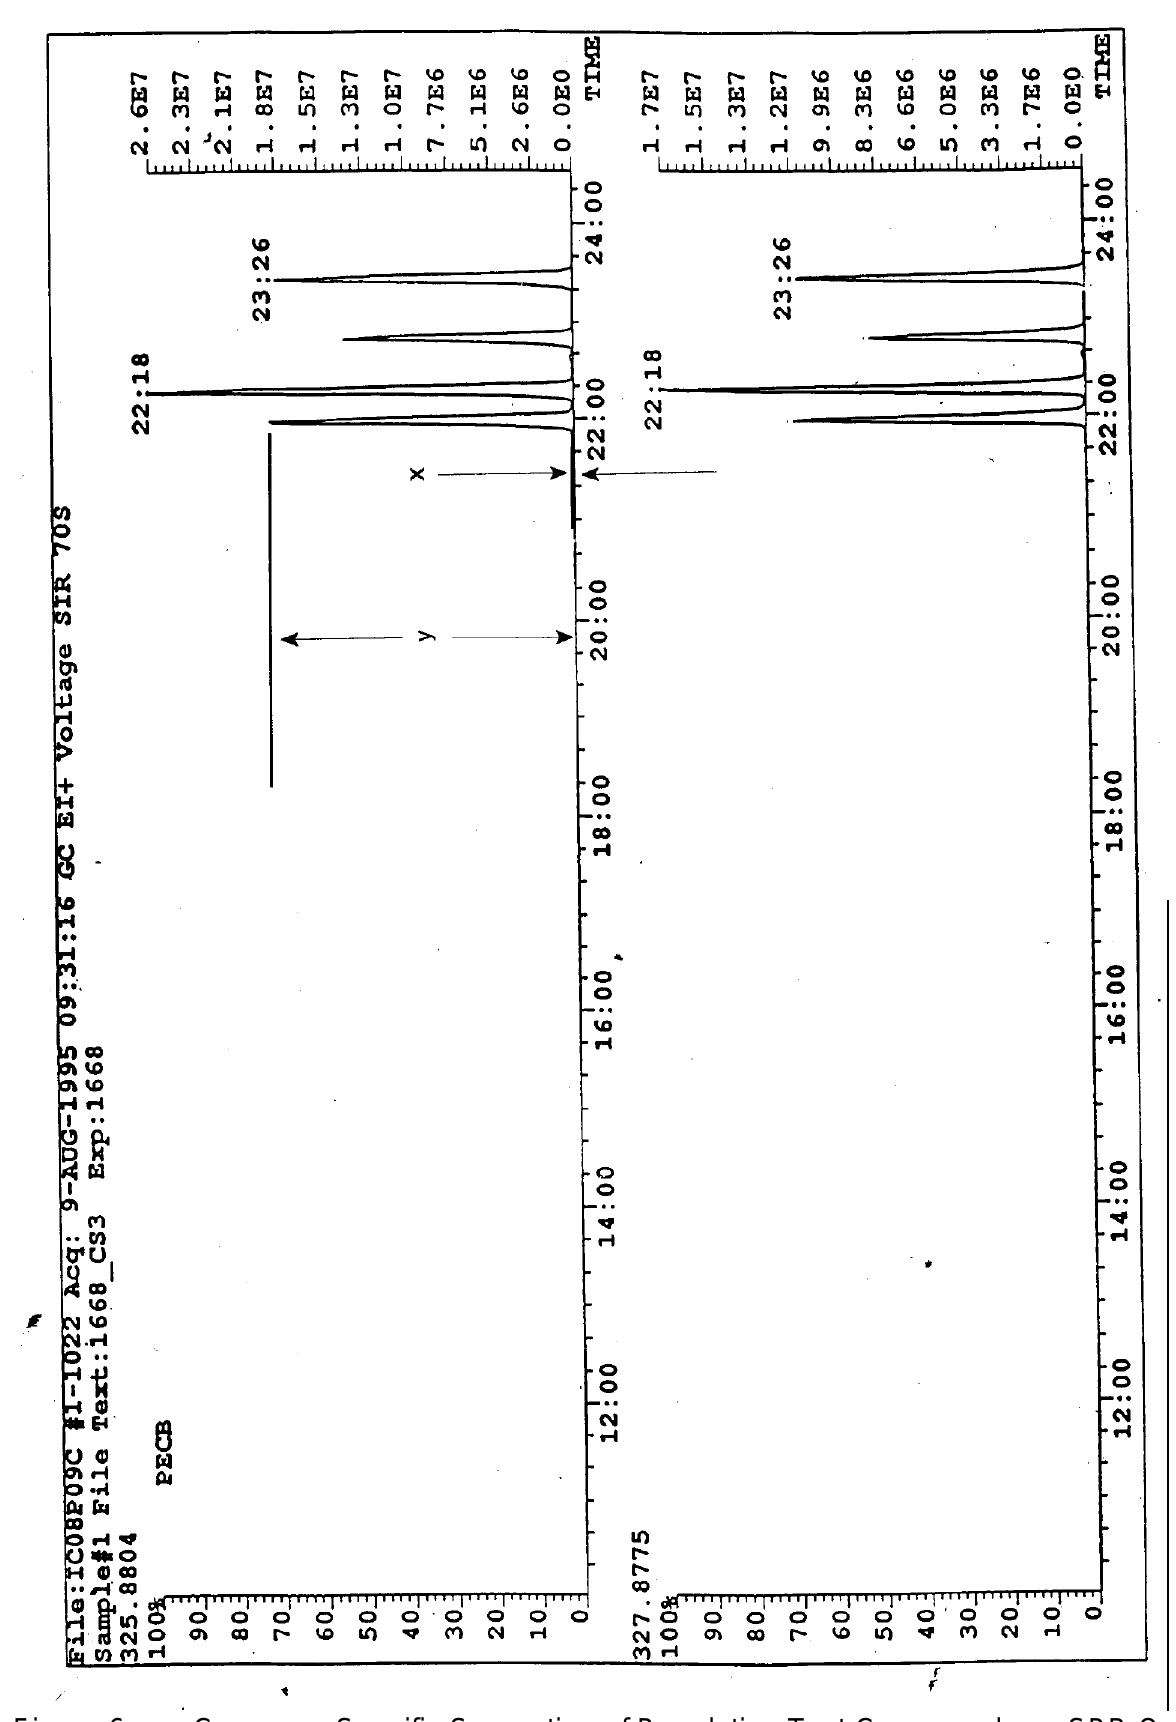
Figure 6 Congener-Specific Separation of Resolution Test Compounds on SPB-Octyl